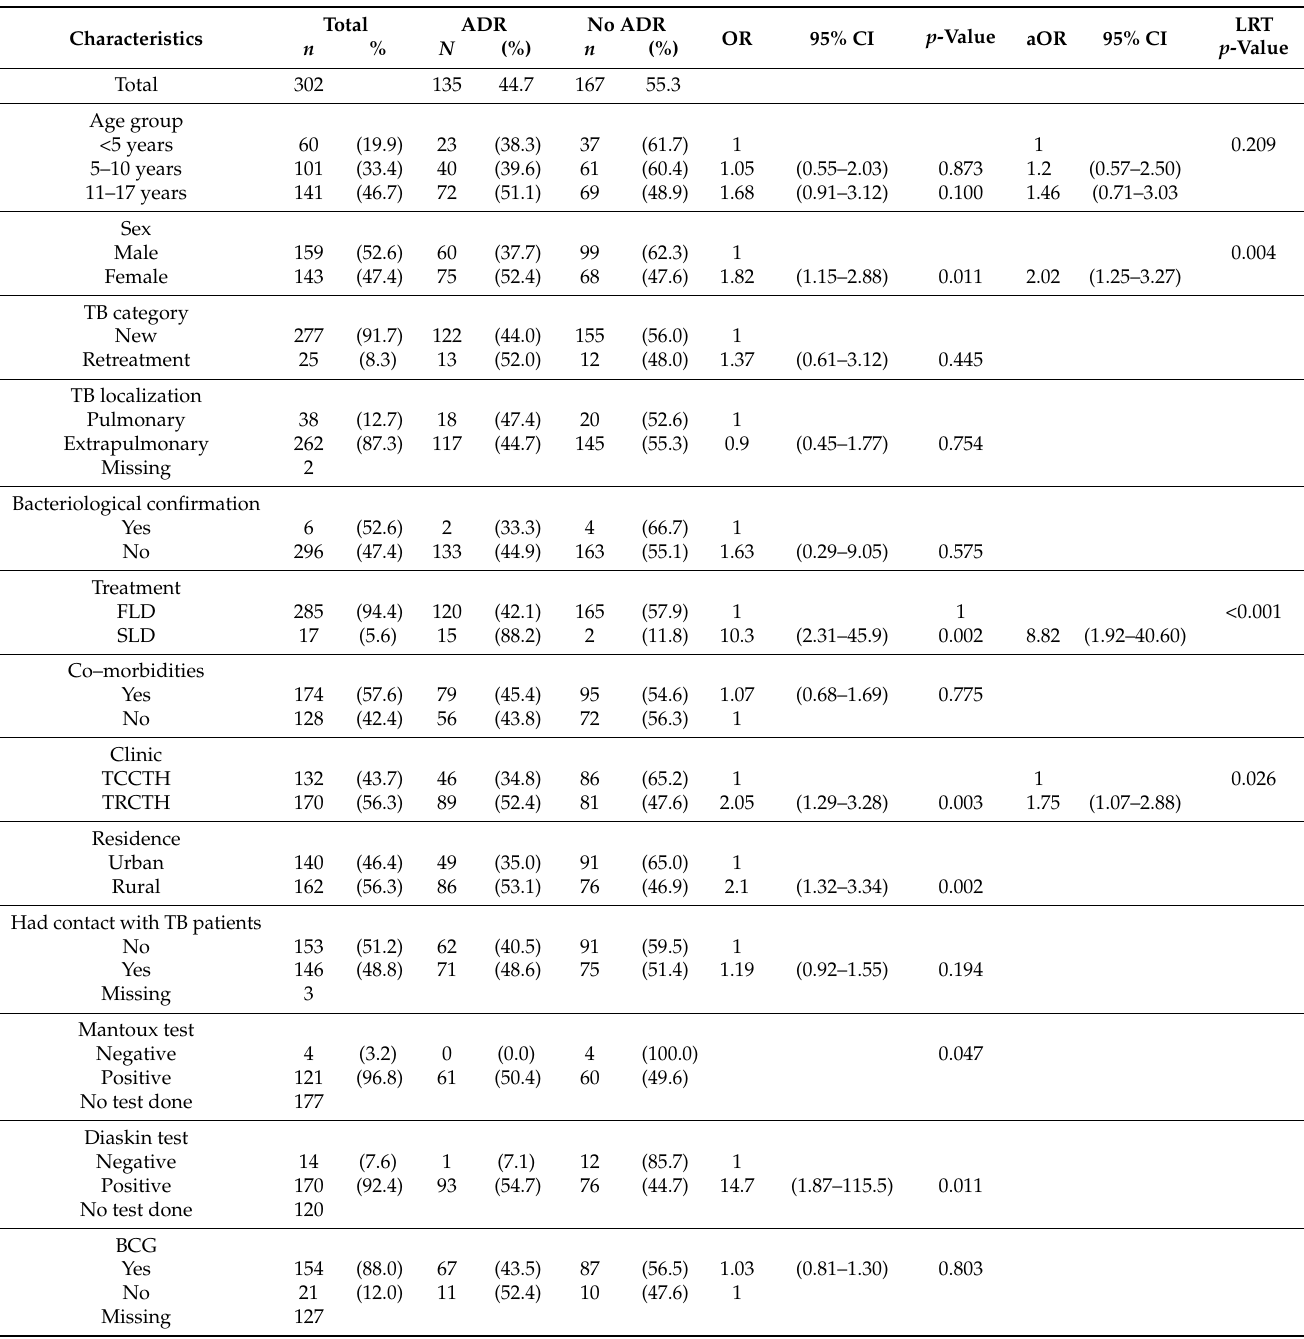
Of all the 302 patients enrolled in the study, a total of 135 (44.7%) patients reported having ADR. Females had two times higher odds of development of ADR compared to male patients (aOR = 2.02; p = 0.011). As expected, the patients enrolled in the second-line TB treatment had nearly nine times higher odds of ADR, compared to those receiving the first-line TB treatment (aOR = 8.82; p = 0.002). Patients who received the treatment at TRCTH had 75% higher odds of ADR than those receiving the treatment at TCCCH (aOR = 1.75; p = 0.003) (Table 6). Table 6. Socio-demographic, clinical characteristics, and factors associated with the occurrence of the adverse drug reactions among pediatric tuberculosis patients registered at Tashkent City Children Tuberculosis Hospital and Tashkent Regional Children Tuberculosis Hospital, Uzbekistan,